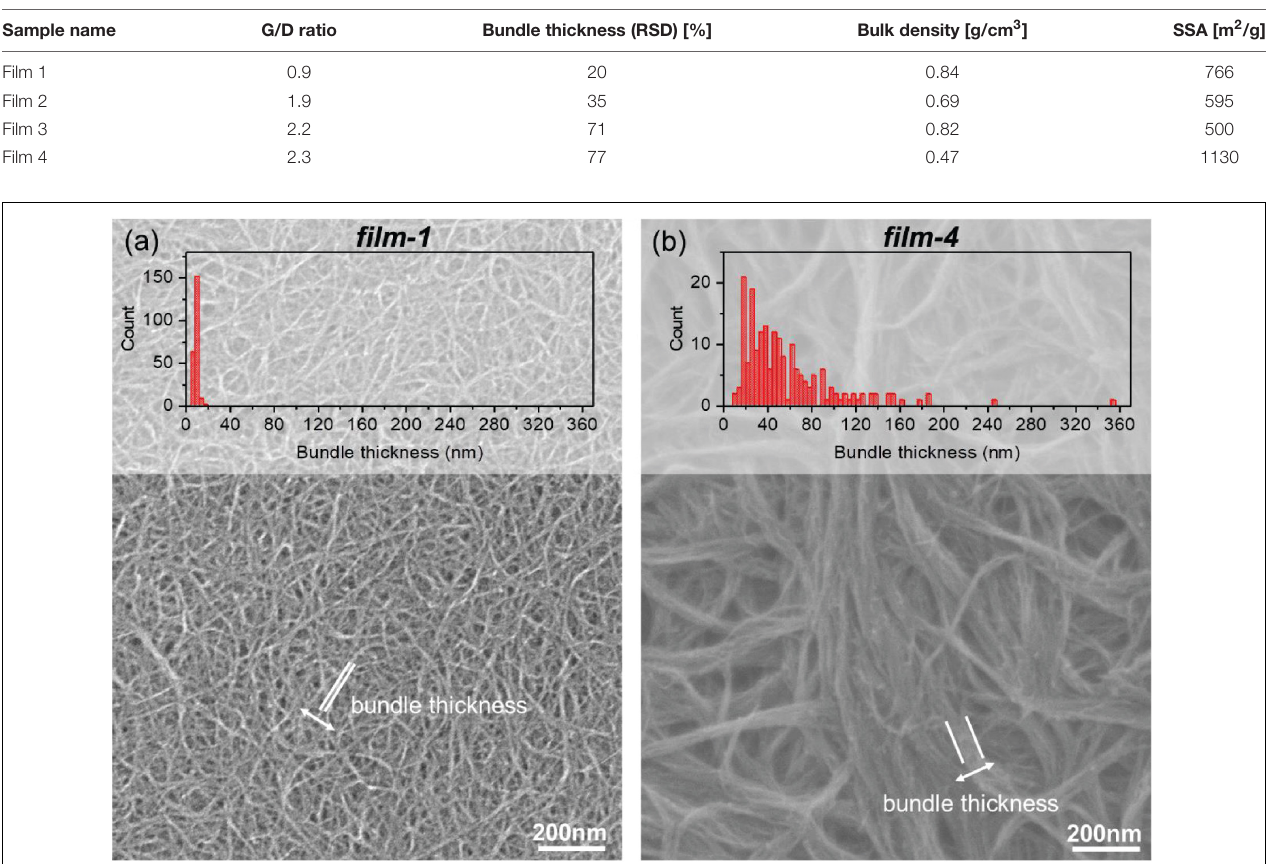
TABLE 2 | RSD of bundle thickness measured by SEM, SSA by gas adsorption analysis, bulk density, and G/D ratio by Raman spectroscopy of the four types of CNT films prepared using four types of suspensions.